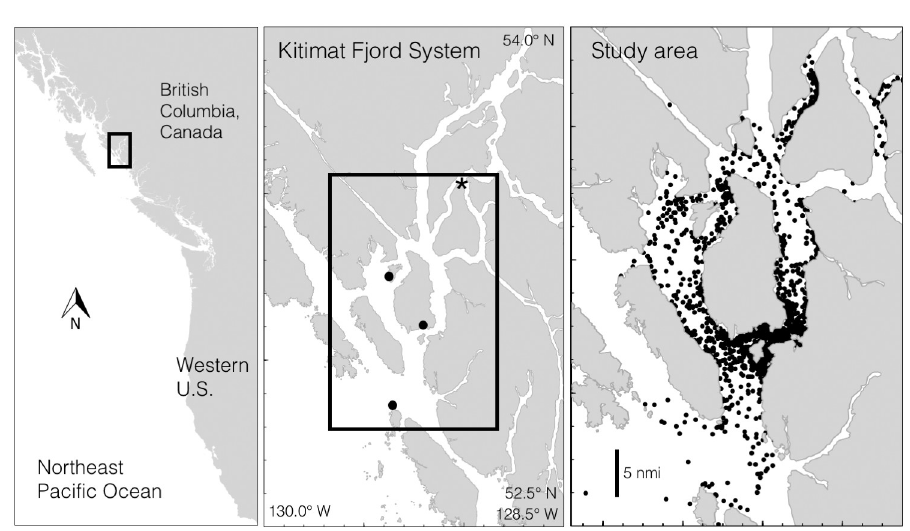
Fig 1. Study area in the Kitimat Fjord System, British Columbia, Canada, within the territories of the Gitga’at First Nation, Kitasoo First Nation, and Haisla First Nation. Center pane : Dots indicate locations of research stations. North to south: Fin Island, Whale Point on Gil Island, and the Wall Islets. Asterisk indicates reference point for fjord position metrics (see main text). Right pane : Dots indicate locations of humpback whale photo-identification events,